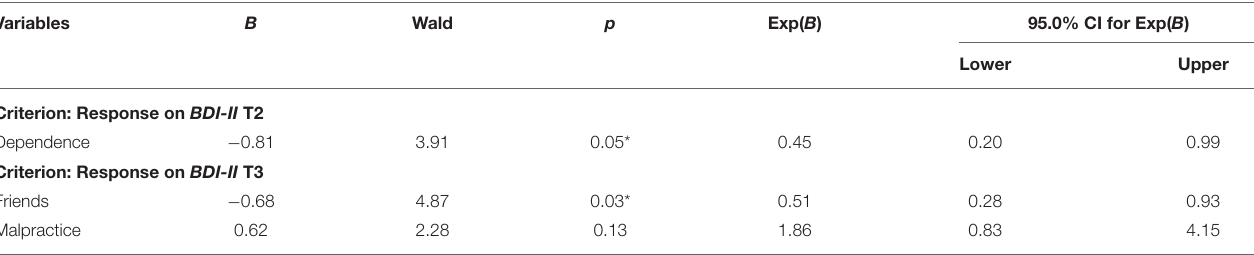
TABLE 3 | Results of the logistic regression of negative effects on treatment response at discharge (T2) and follow-up 6 months after discharge (T3) measured by Beck Depression Inventory (BDI-II).